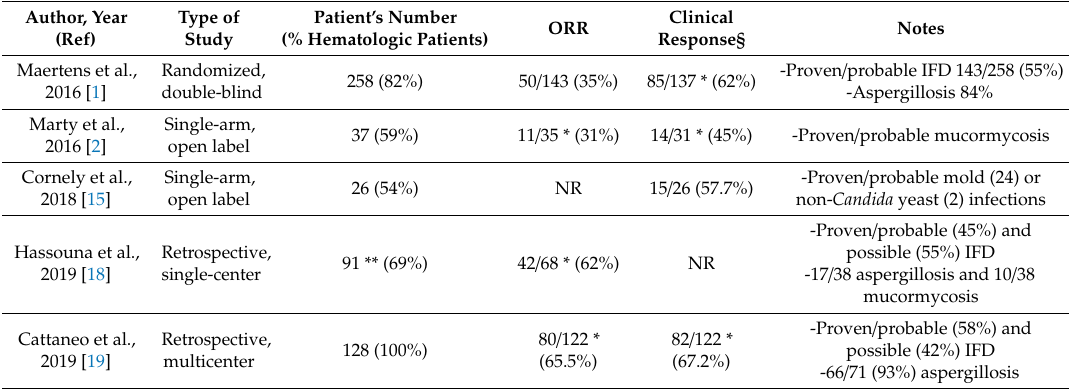
Table 1. Isavuconazole treatment in hematological malignancies patients with